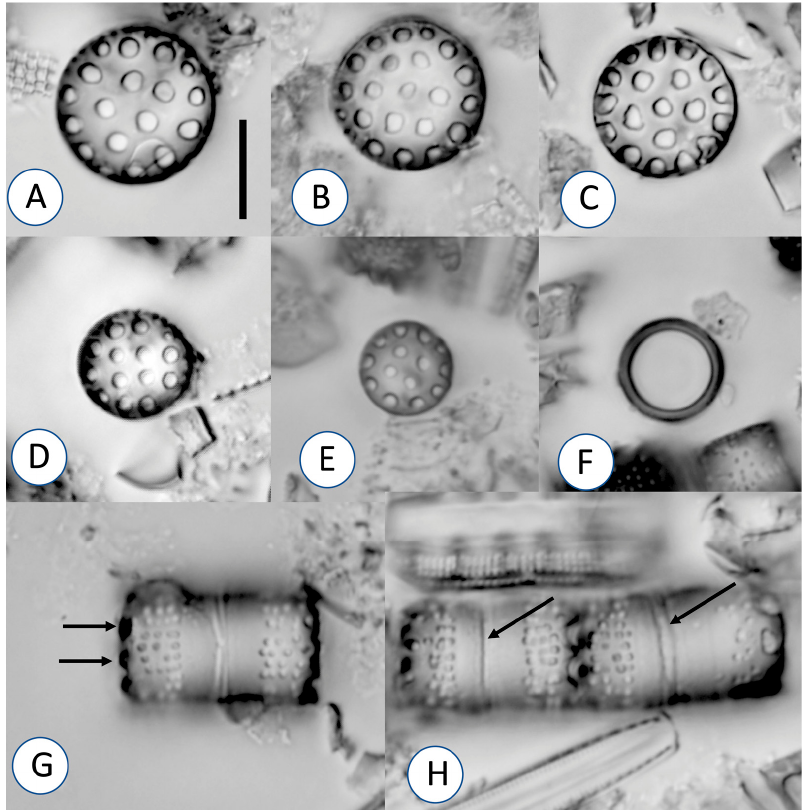
Figure 1. ( A – H ) Aulacoseira wyomingensis , sp. nov. Light microscopy. ( A – E ) Valve views. Size diminution series. ( F ) Ringleiste. ( G , H ) girdle views. Arrows indicate small, spine-like protrusions ( G ) and collum ( H ). All specimens are from the holotype slide. Scale bar = 10 µm for all images. In the SEM, externally, the areolae on the valve face are seen as forming depressions occluded by volae (Figure 2A–D). Short, blunt, spine-like protrusions originate from the mantle (Figures 2C and 3A–C), shield-like, but absent from some valves. The cingulum is comprised of many narrow, ligulate bands (Figure 3A–C). The collum is ornamented with siliceous ridges (Figure 3A–C). Internally, individual areolae are covered by fine, hymen- ate occlusions (Figure 4A,C,D). Rimoportulae have not been observed (Figure 4A–C,E).